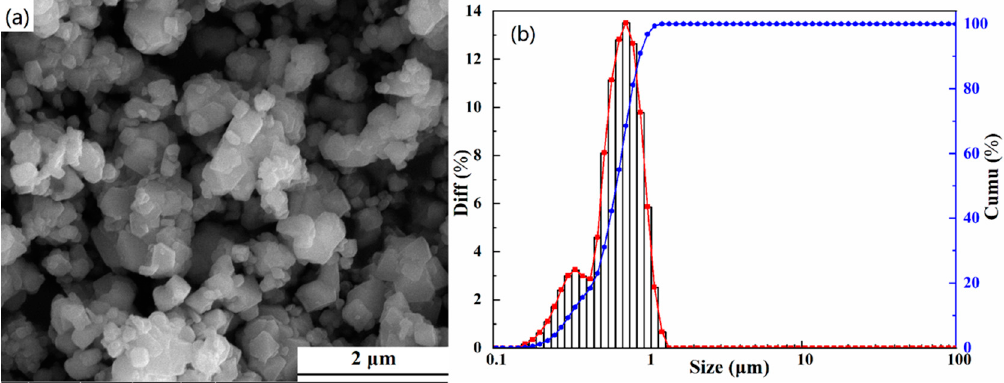
Figure 2. SEM image ( a ) and particle size distribution ( b ) of (FeCoCrMnZn) 3 O 4 powders (900 °C, 2